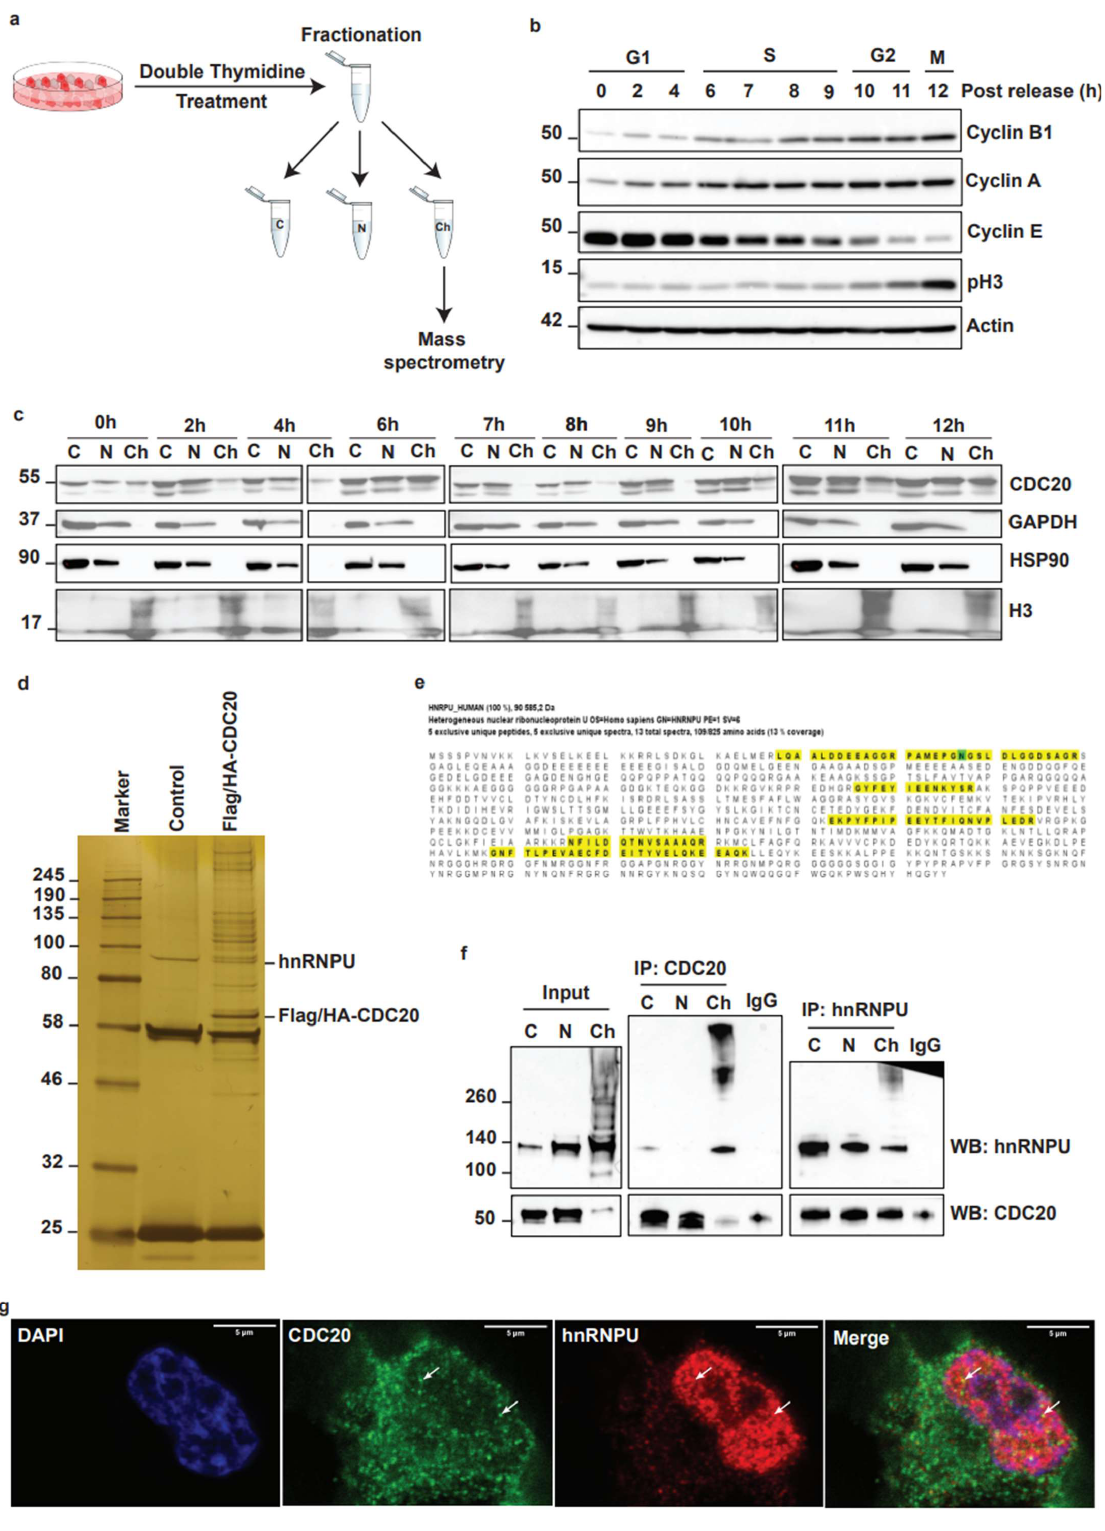
Figure 3. Identification of nuclear matrix protein hnRNPU as a target for CDC20 during chromatin dynamics. ( a ) Experimental Flow Chart ( b ) Validation of the efficiency of cell cycle synchronization in MDA-MB-468 cells. MDA-MB-468 cells were synchronized by double thymidine treatment and then released at different time points. The whole-cell lysates were subjected to Western blot analysis using the indicated antibodies. ( c ) Immunoblot analysis of CDC20 expression in different